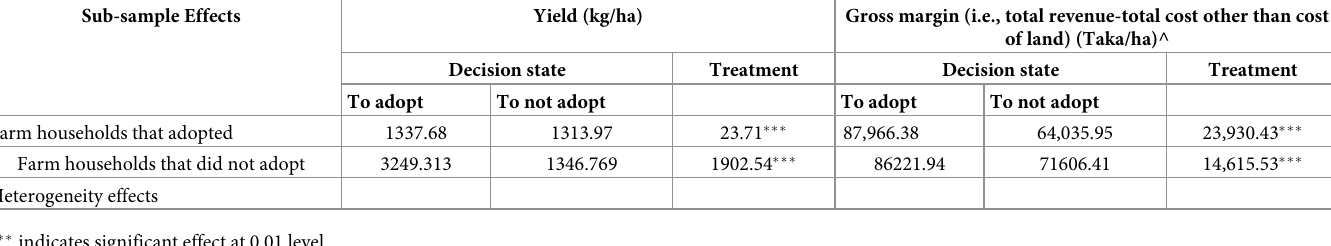
Table 6. Results from endogenous switching regression (ESR) showing average treatment effects of adoption of improved lentil varieties on yield, and gross